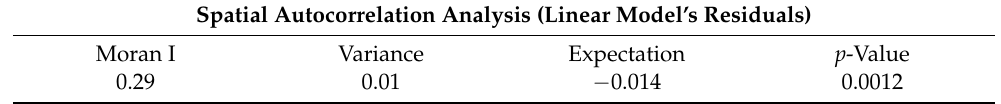
Table 7. Linear model coefficients with related